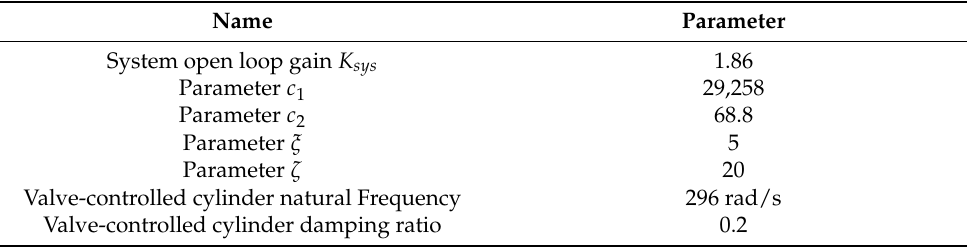
Table 3. Parameters of exponential reaching law SMC